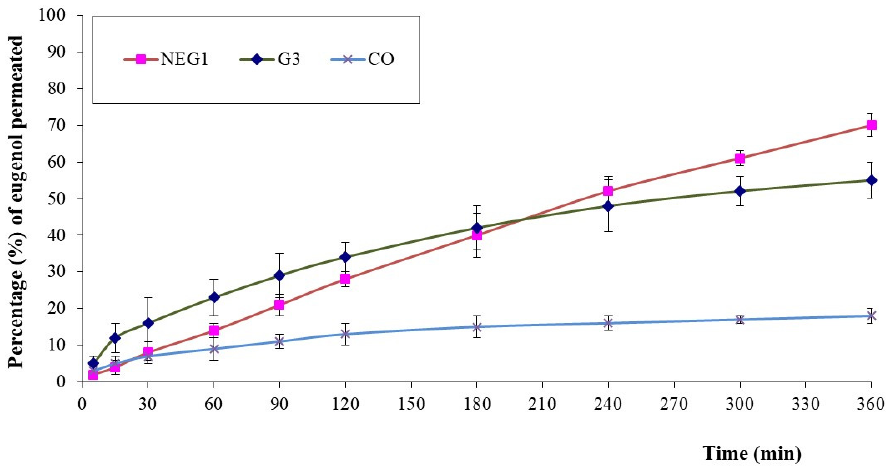
Figure 7. Results of ex vivo skin permeation of eugenol (marker molecule for CO) from HPC hydrogel loaded with optimized CO-NE (NEG1), aqueous dispersion of CO-NE without HPC gel base (G3), and pure cinnamon oil (CO).